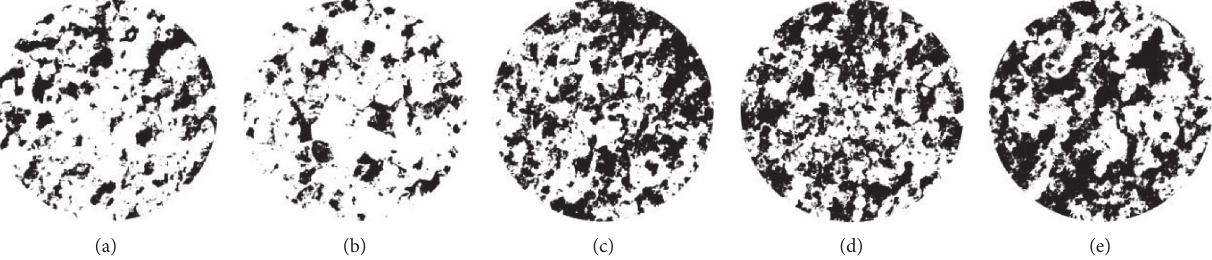
Figure 6: Pore extraction.